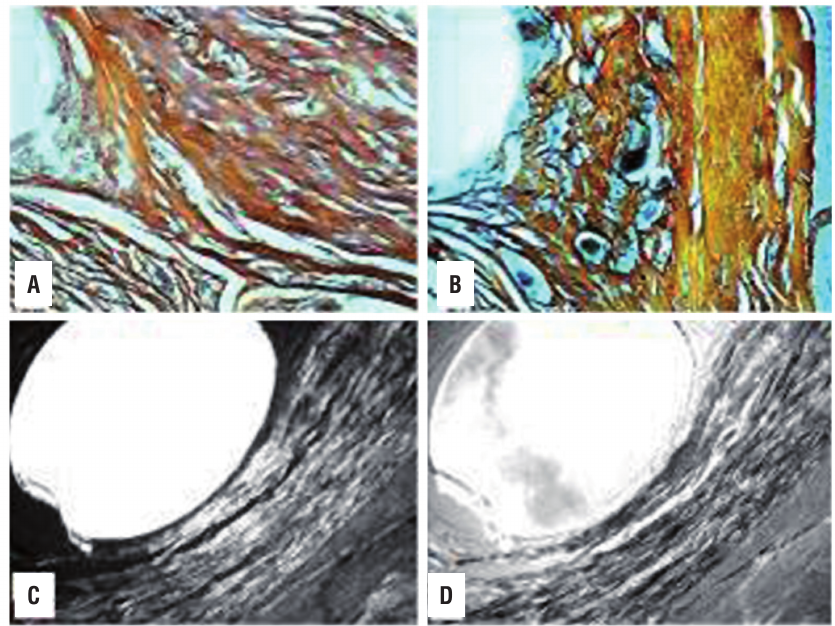
Figure 2 - Highly Purified Collagen Gel Coating Polypropilene Mesh presenting higher birefringence level of collagen fibers, thus reflecting an improved molecular organization of newly formed collagen. A and B) Image of section impregnated with silver (Ag) 90 days after implantation. PP (A) and PP+C (B) where the packing arrangement of collagen fibers is demonstrated. Ag, 40×1. C and D) Unstained section immersed in water (PP+C 90 days after implantation), showing filament cut perpendicularly, through collagen fibers with various brightness intensities. Birefringence is revealed by brightness contrasted with a dark background. B. Same image, after compensation, in which collagen fibers appear dark.